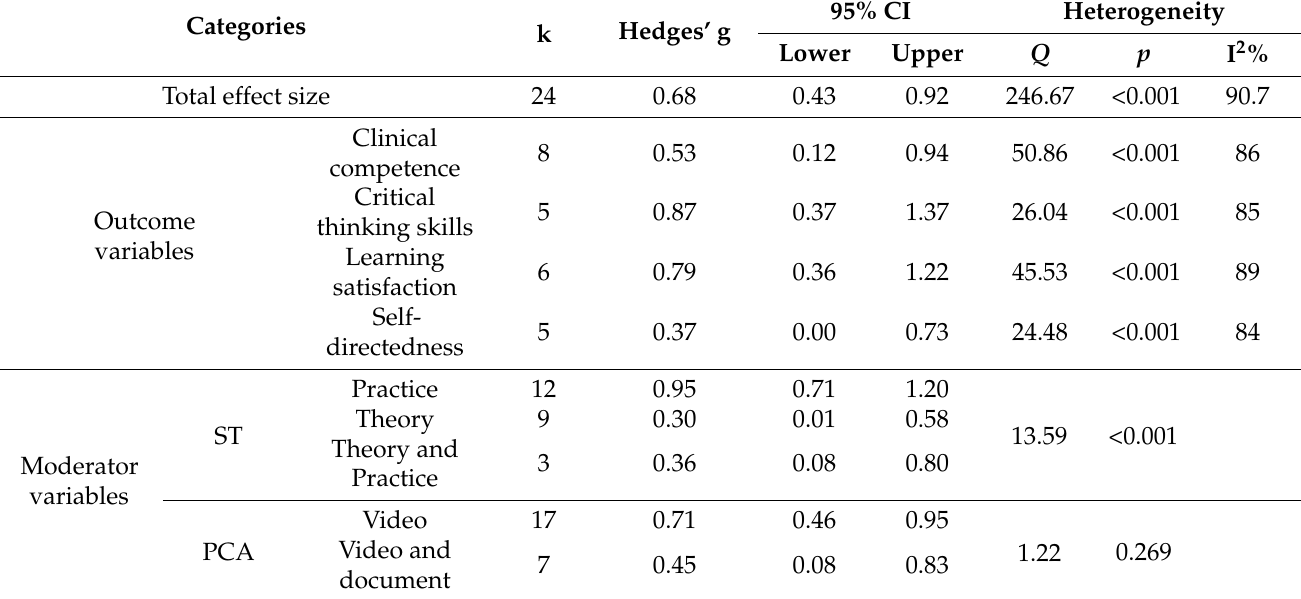
Table 2. Effects of outcome and moderator